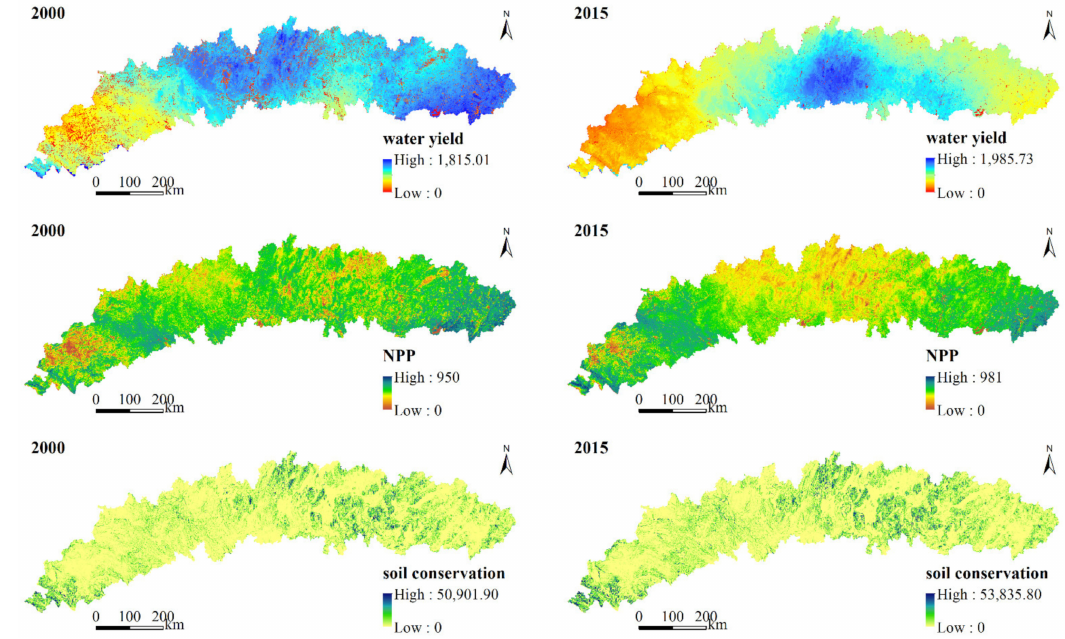
Figure 4. Spatiotemporal variation in ESs from 2000 to